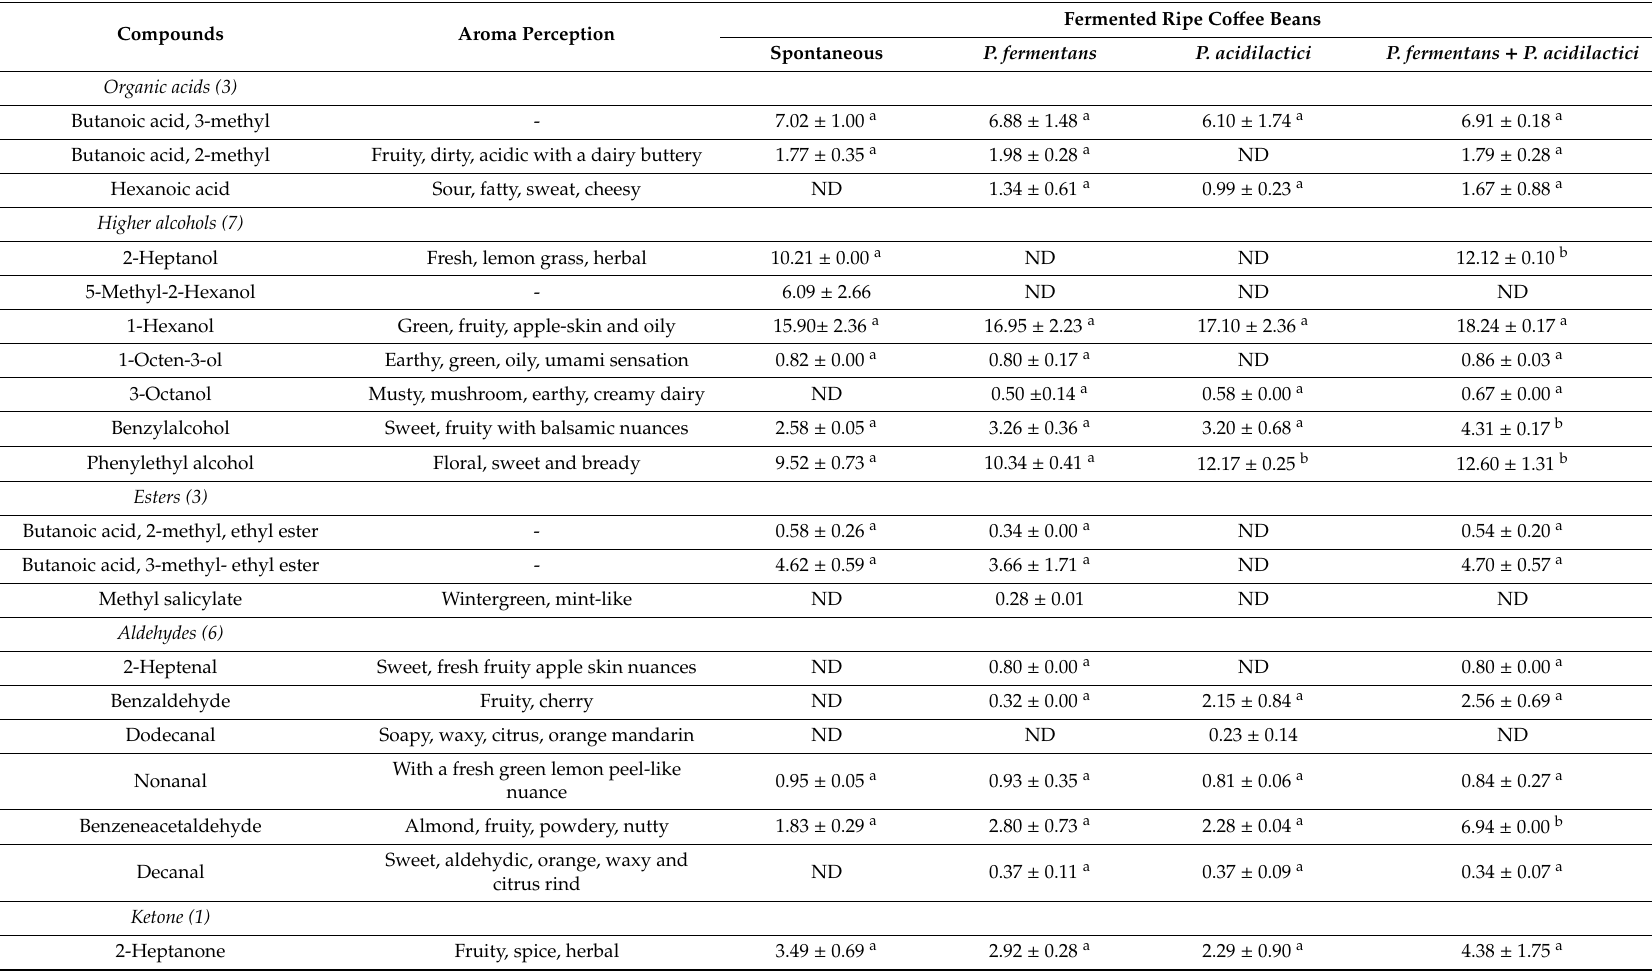
Table 1. Concentration of volatile compounds (Area*10 5 ) in ripe co ff ee beans after single cultures, a combined treatment, and a spontaneous assay. Means of triplicate in each row bearing the same lowercase letters (a, b) are not significantly di ff erent ( p > 0.05) from one another using Duncan’s Test (mean ± standard